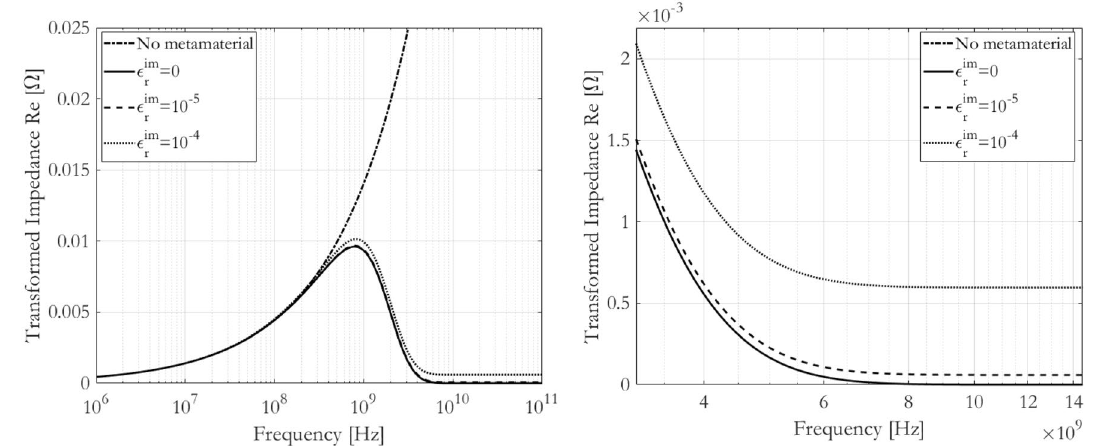
Figure 3. (Left) Real part of transformed impedance according to values in Table 1 for lossy cases. (Right) Zoom on a reduced frequency range, beyond the metaconductive